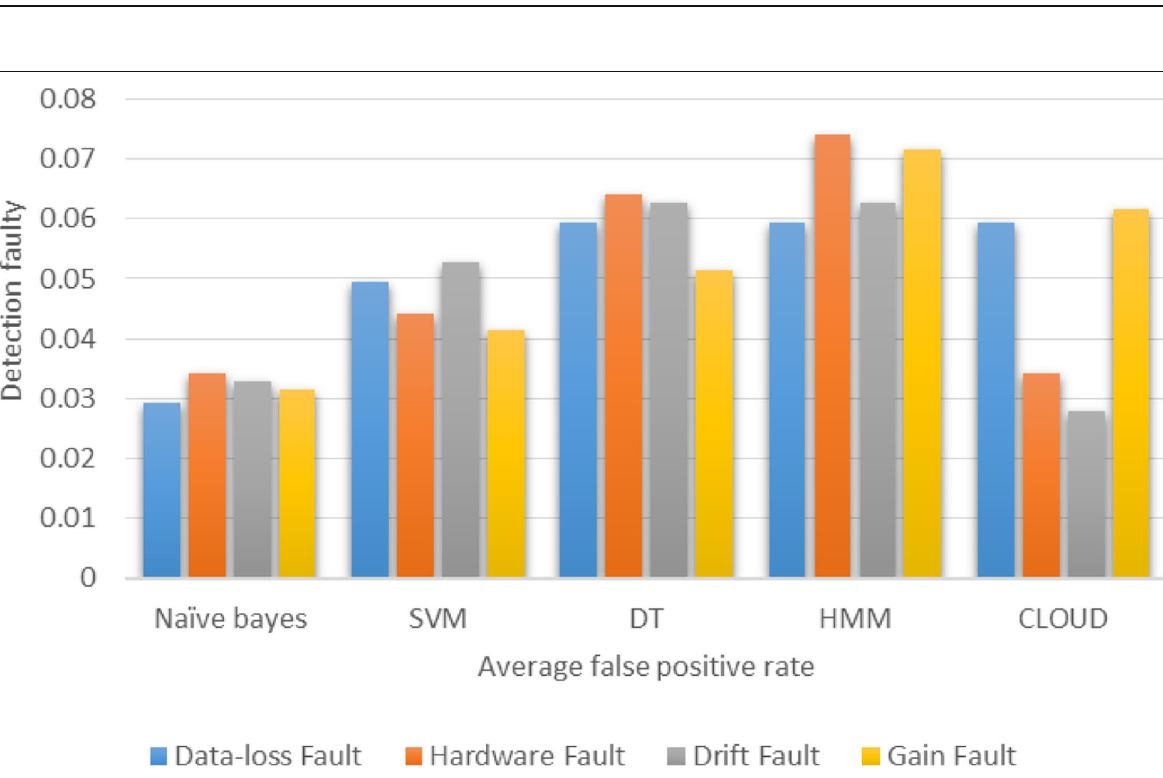
Fig. 10 Comparison of the proposed method for the classification of a collecting temperature dataset with the SVM, DT, HMM and CLOUD methods on concerning the FPR